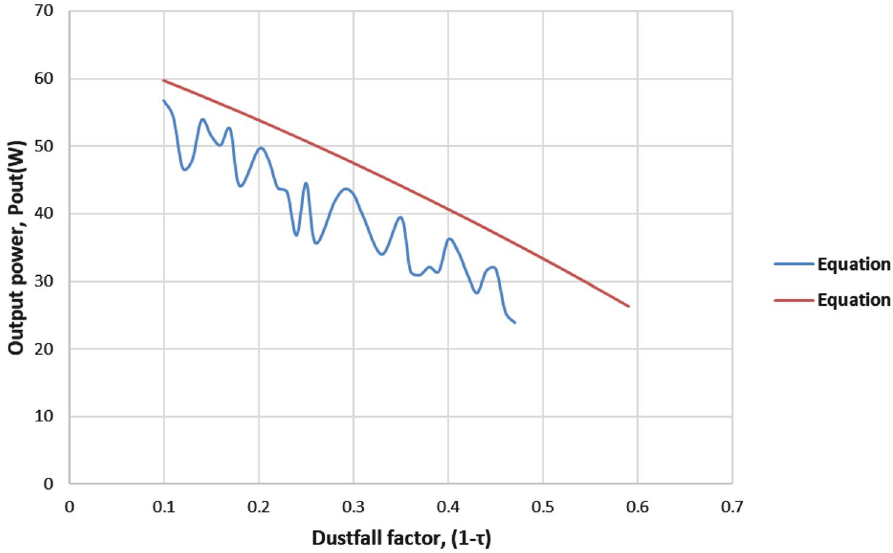
Fig. 6 Comparison of P out ratio calculated from Eq. (4) and from quadratic regression Eq. (5) based on